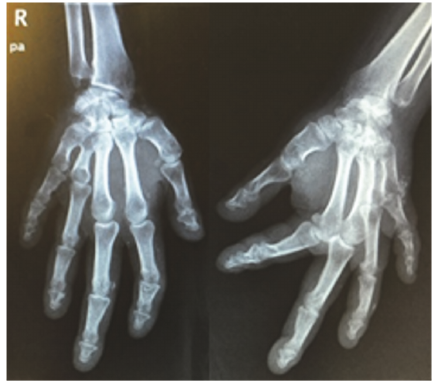
Figure 1: Radiography of both hands, revealing brachydactyly of the fourth and fifth metacarpals.